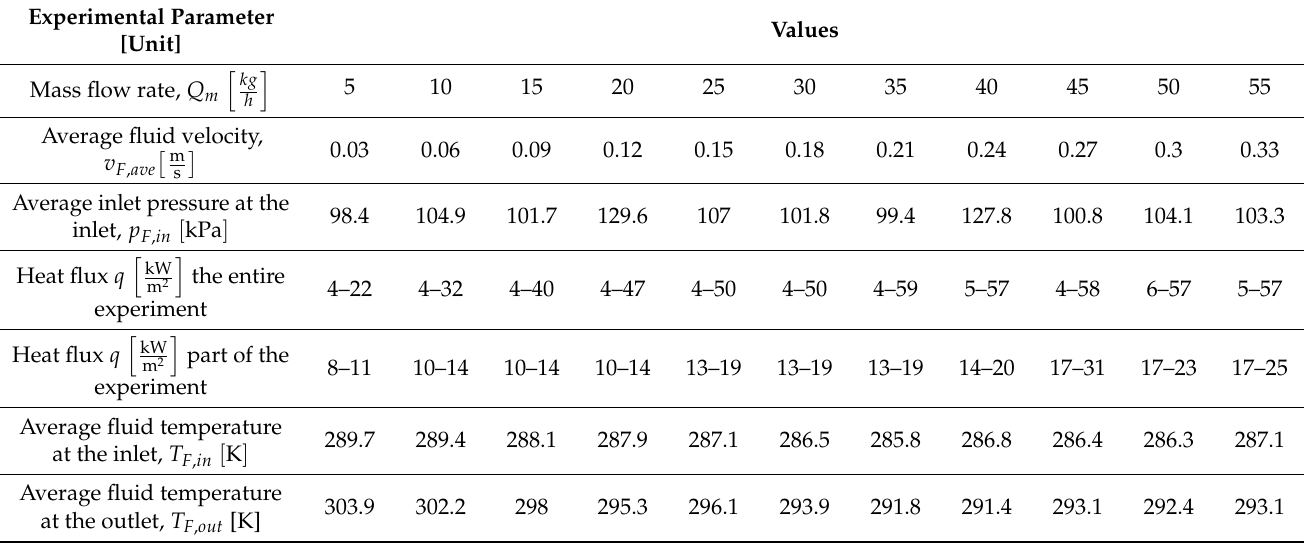
Table 1. The basic data and parameters of the experimental series.